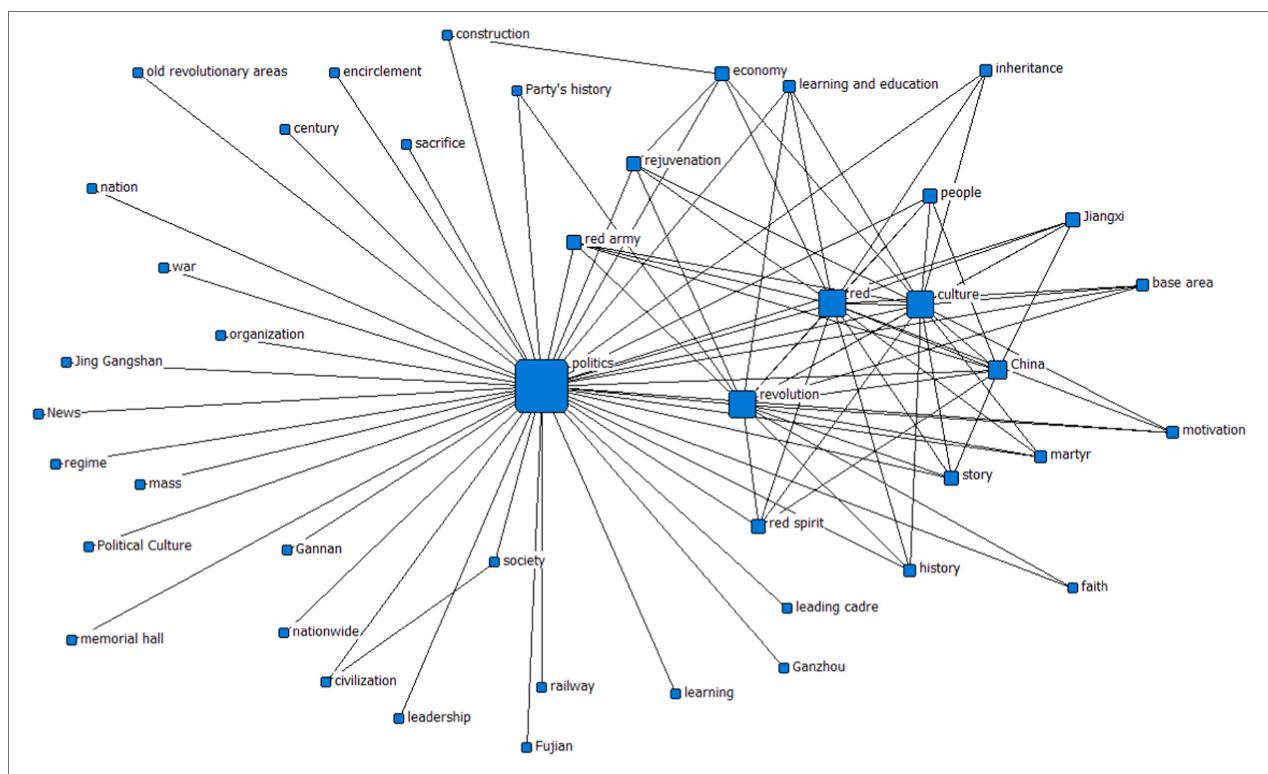
FIGURE 1 | Semantic matrix graph of political culture perception